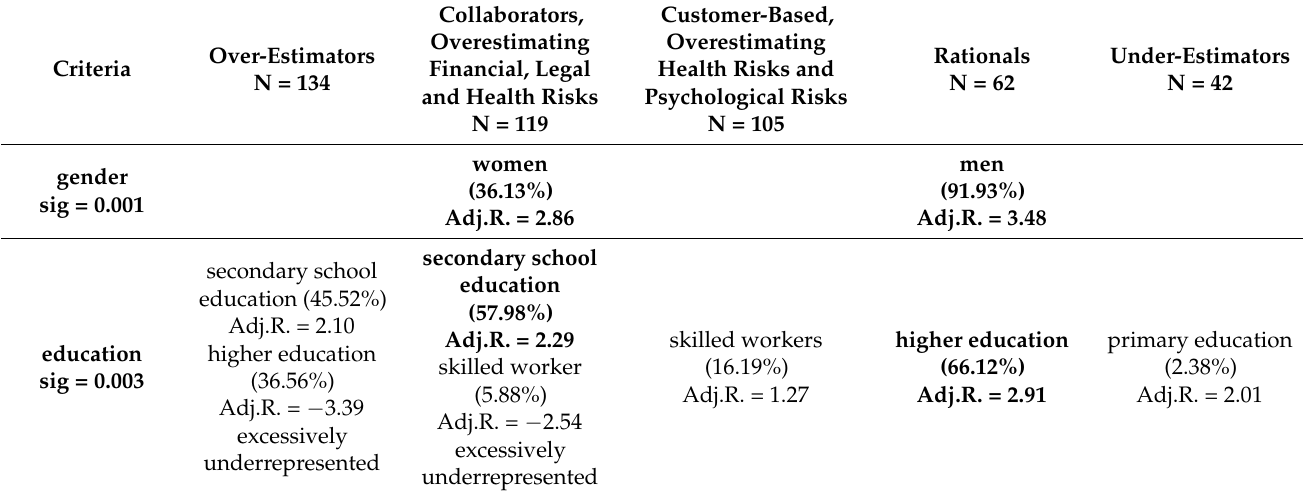
Table 8. Socio-demographic characteristics of the construction segments according to the perceived risk factors. Source: authors’ own research, 2018. Measurement levels: nominal, attributes = clusters chi-square test, Adj = corrected standardized residences, % = column percentage the variable rate of the exam in the